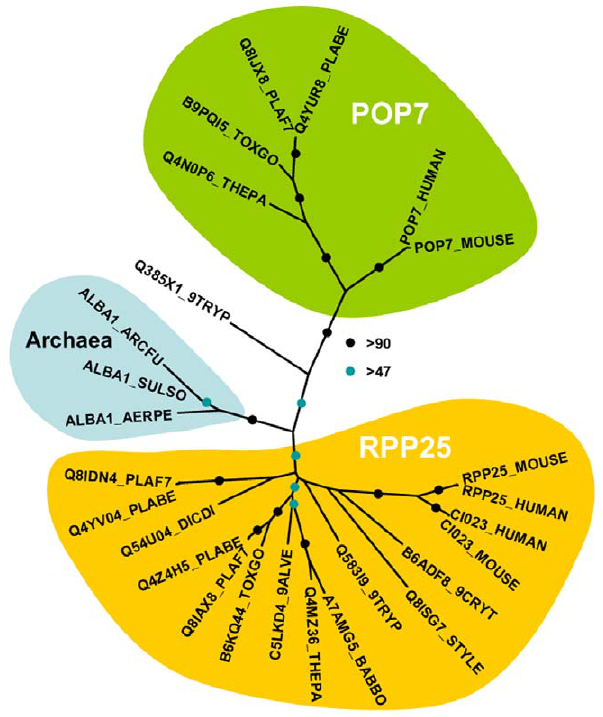
Figure 2. Phylogenetic position of Plasmodium Alba-domain proteins. We generated a multiple sequence alignment of the conserved region of a range of Alba-domain proteins (PFAM PF01918). The phylogenetic tree was generated with PHYML. Bootstrap values (100 replicates) are based on neighbor joining and maximum likelihood analyses. Accession numbers are from uniprot; species abbreviations are for Perkinsus marinus (9ALVE), Cryptosporidium muris (9CRYT), Trypanosoma brucei (9TRYP), Aeropyrum pernix (AERPE), Archaeoglobus fulgidus (ARCFU), Babesia bovis (BABBO), Dictyostelium discoideum (DICDI), Plasmodium berghei (PLABE), Plasmodium falci- parum (PLAF7), Stylonychia lemnae (STYLE), Sulfolobus solfataricus (SULSO), Theileria parva (THEPA) and Toxoplasma gondii